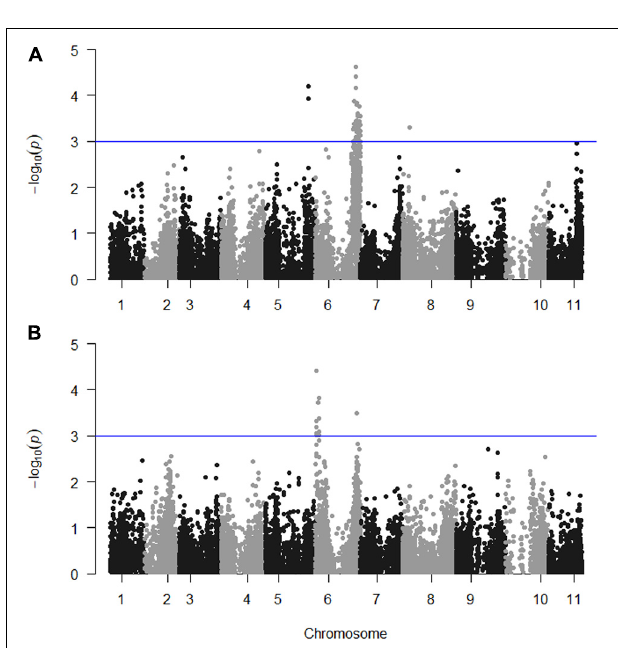
FIGURE 3 | Manhattan plots showing the significance of the markers on the weevil resistance traits; (A) PD (logit_PD) and (B) TXD (logit_TXD). The blue line indicates the significance threshold set at p =